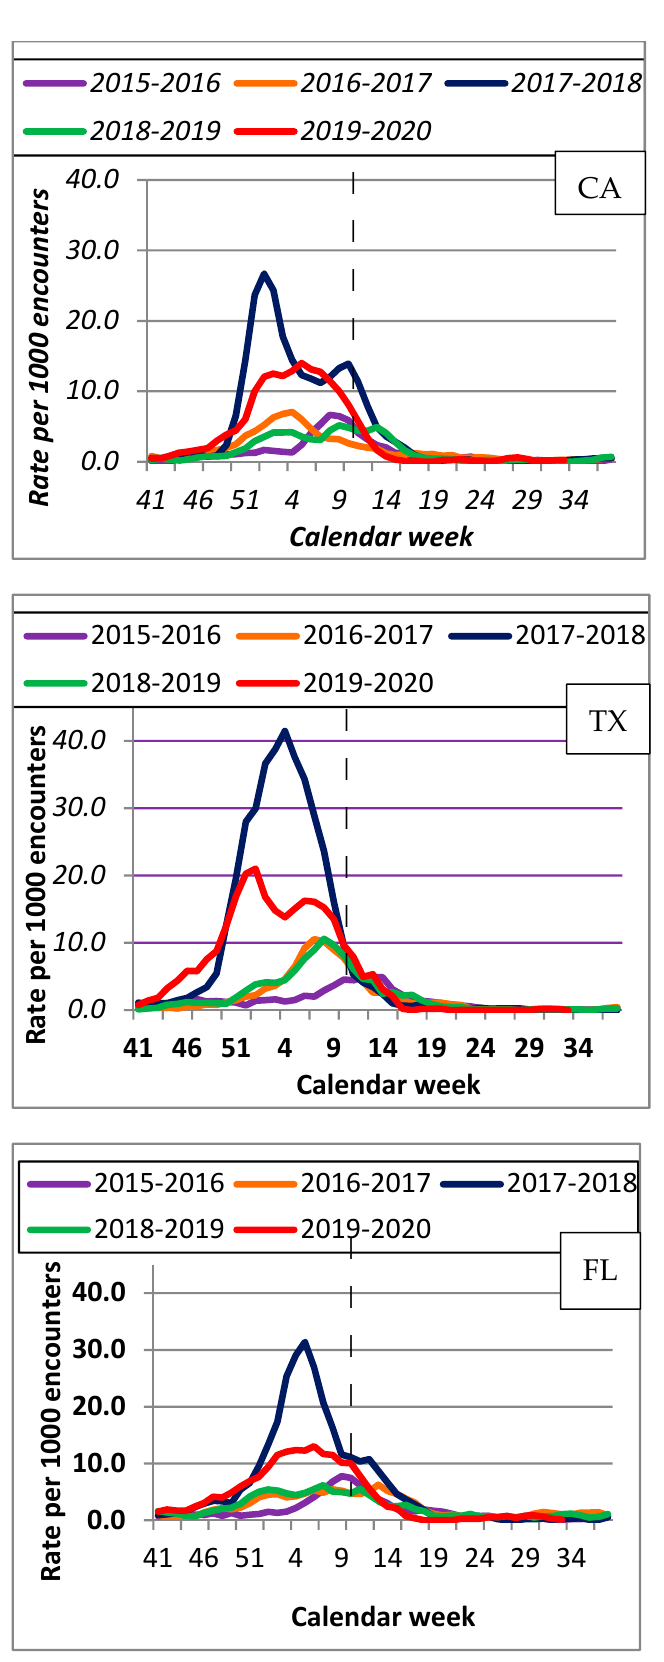
Figure 2. Rates per 1000 ED encounters for influenza diagnoses by state (CA, TX, FL) for 5 flu seasons (2015–2020).